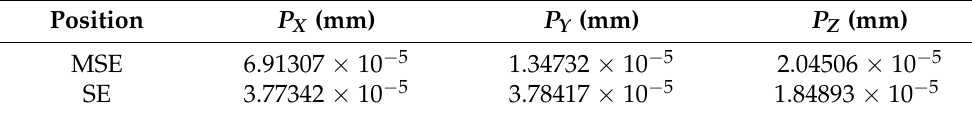
Table 7. Mean Squared Error (MSE) and Standard Error (SE) of the Forward Kinematics.